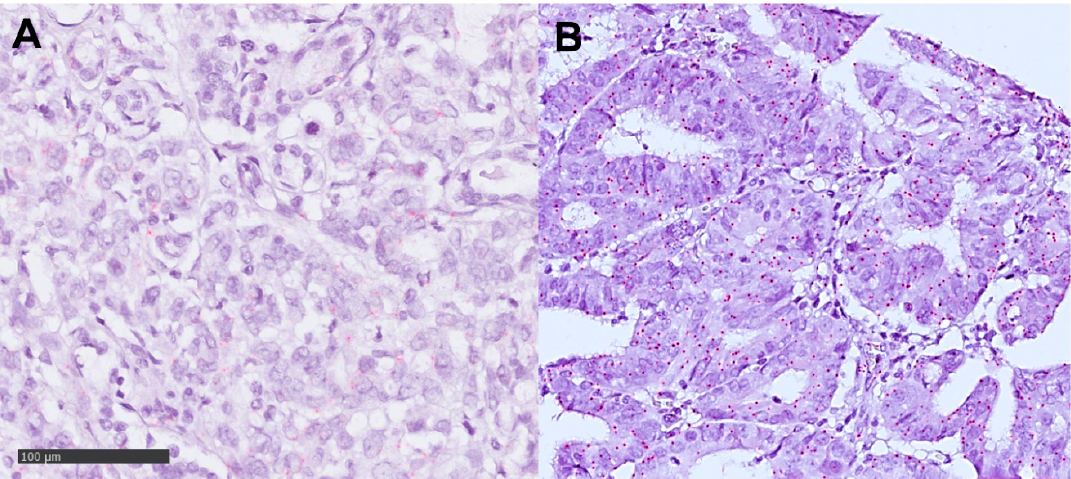
Figure 2. RNA ‐ Scope analysis of mi ‐ RNA221 in esophageal adenocarcinomas; magnification x400 ( A ) negative tumor cells with less than 1 red signal in 10 tumor cells; ( B ) mi ‐ RNA221 expression in tumor cells (red signals).